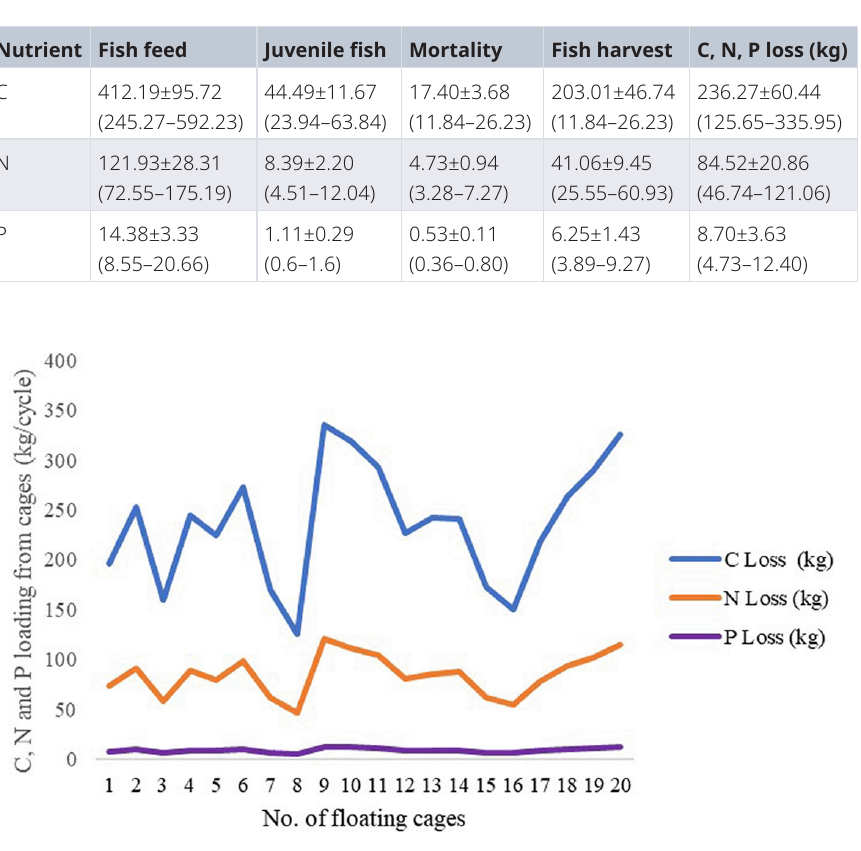
Table 2. Carbon (C), nitrogen (N) and phosphorus (P) mass balances estimated from the 20 floating cages (mean ± SD in kg/cage/cycle), and the numbers in parentheses are the range of the nutrient mass balances of C, N and P from the feed, juvenile fish, dead fish and harvested fish